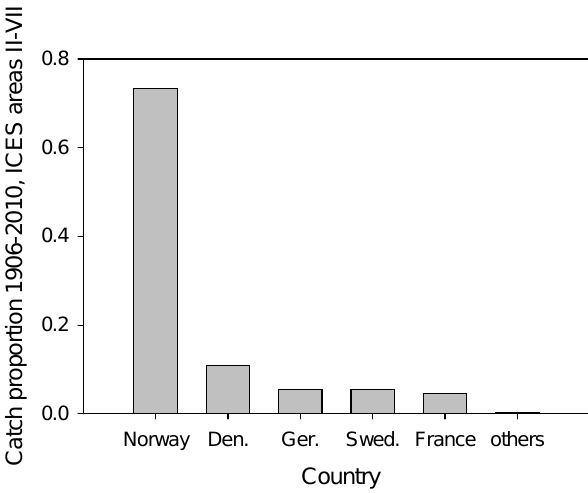
Figure 13. Proportion of total landings in ICES areas II–VII during 1906–2010. Data sources include ICES catch databases (versions downloaded 21 January 2014) and other historical sources – see PANGAEA link for